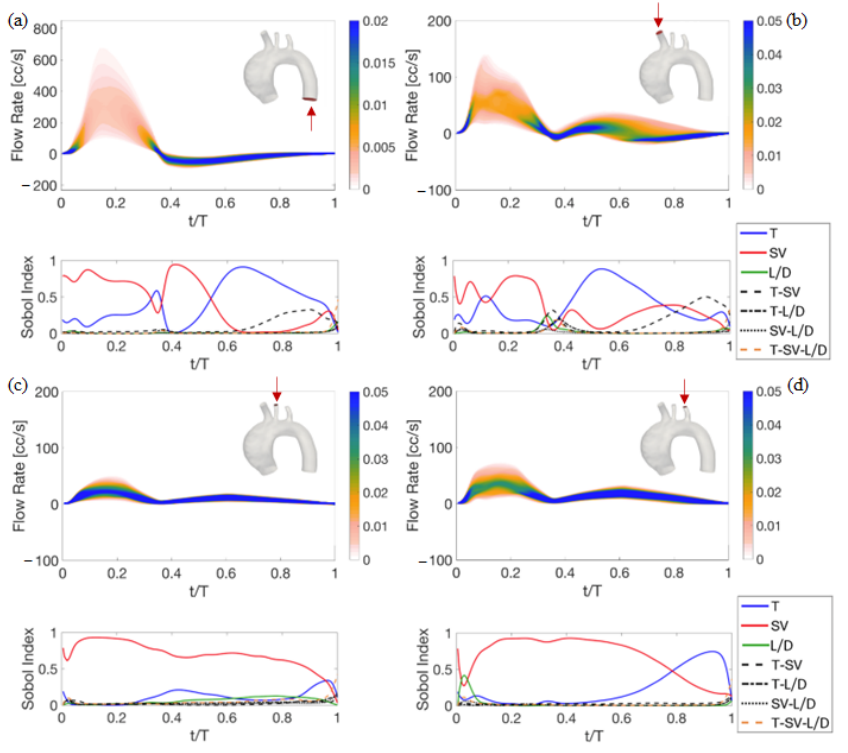
Figure 14. PDF of the waveforms of the flow rate (top panel) and relative Sobol indexes (bottom panel) at the four outlets of the aneurysmatic aorta: ( a ) DA, ( b ) BCA, ( c ) LCCA, and ( d )